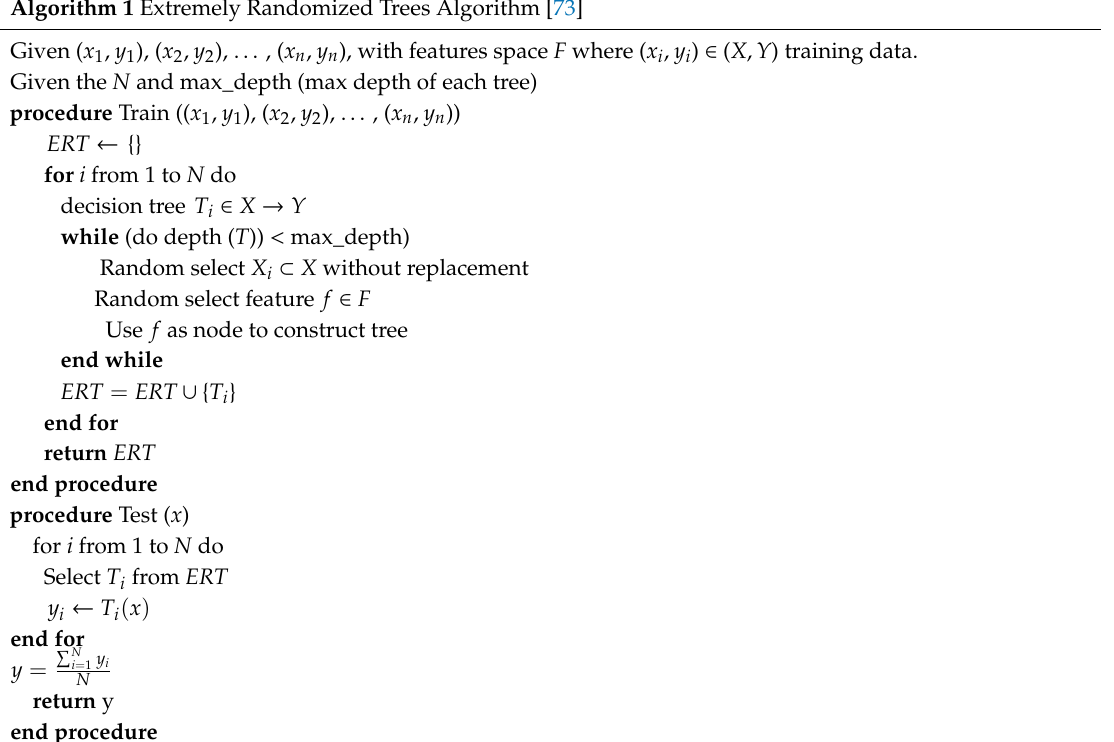
Algorithm 1 Extremely Randomized Trees Algorithm